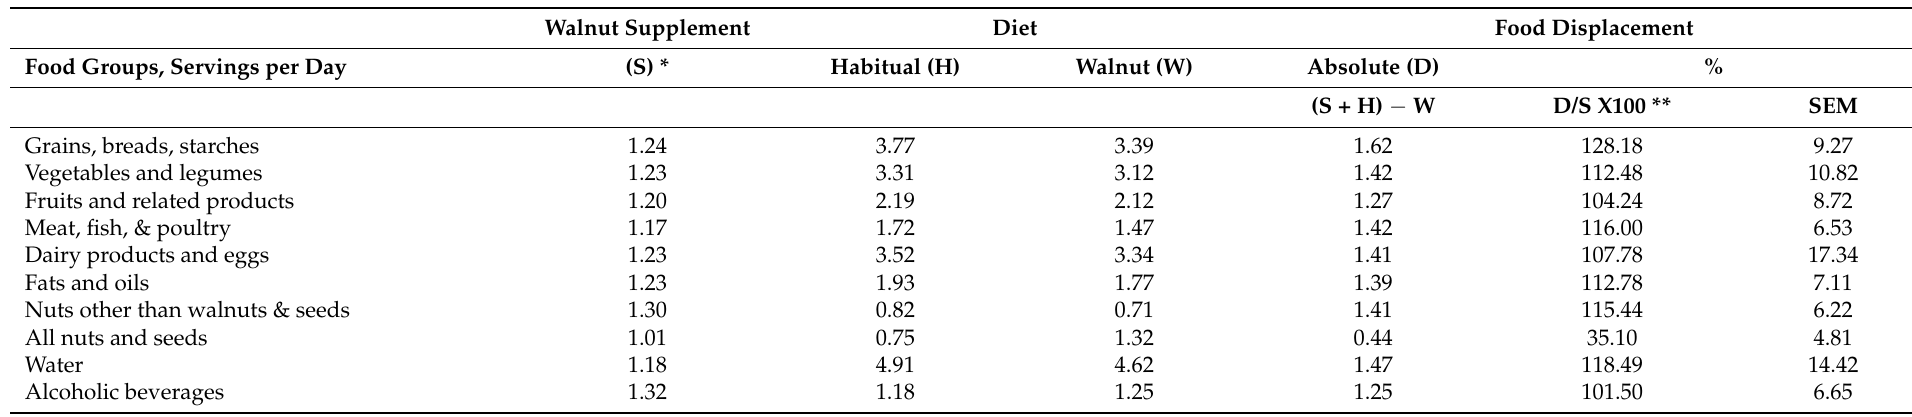
Table 4. Displacement of macronutrient content of foods after 6 months of walnut supplementation. All values are means of reported intake on 7 24-h